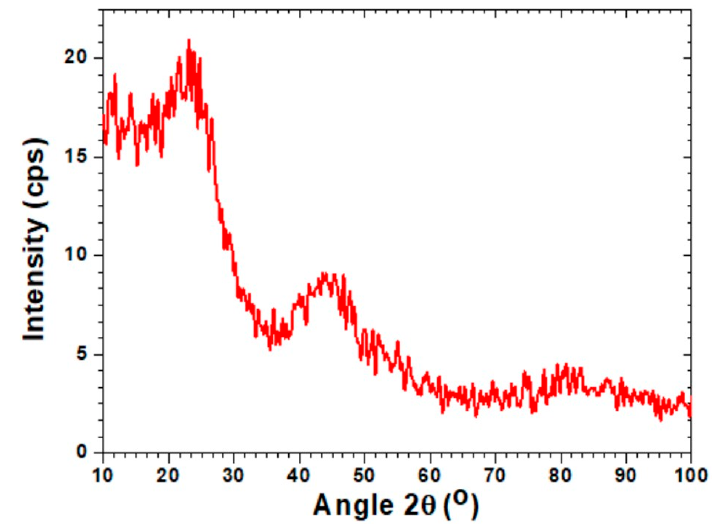
Figure 5. XRD analysis of synthesized activated carbon AC-SY.